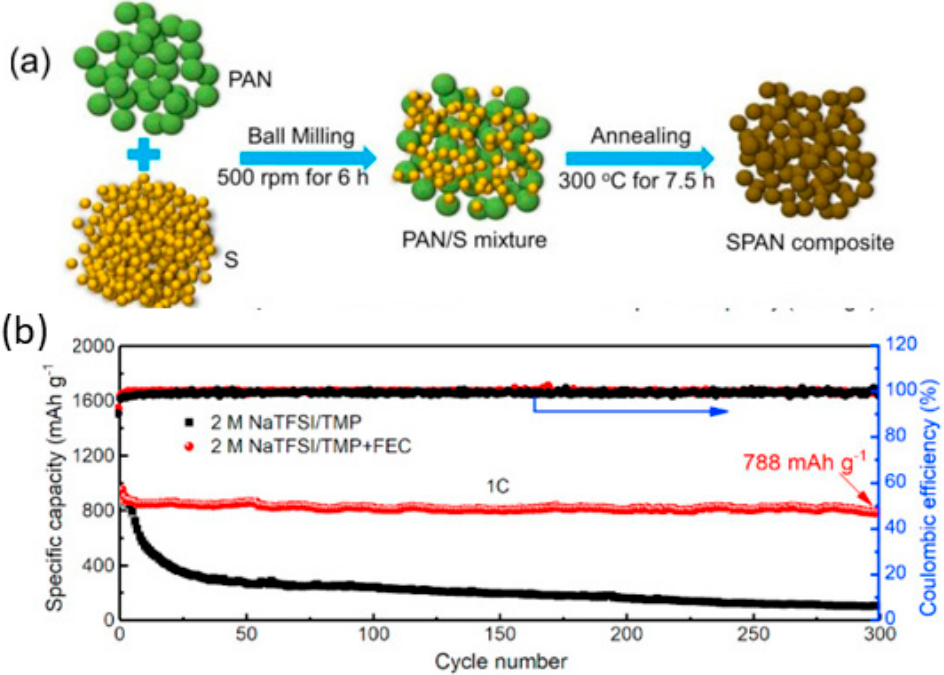
Figure 2. ( a ) Schematic illustration of the synthesis procedure; ( b ) cyclic performance of Na/Span cells with 2M NaTFSI/ TMP electrolytes at 1C [18]. Reprinted with permission from Wu, J.; Liu, J.; Lu, Z.; Lin, K.; Lyu, Y.Q.; Li, B.; Ciucci, F.; Kim, J.-K.; Non-flammable electrolyte for dendrite-free sodium-